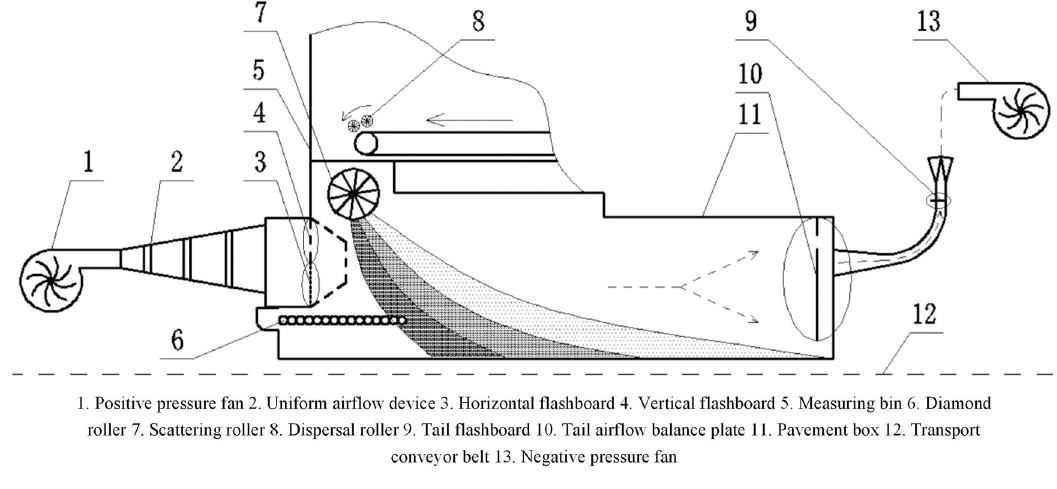
Fig 1. Schematic diagram of the principle of the particleboard airflow forming machine.